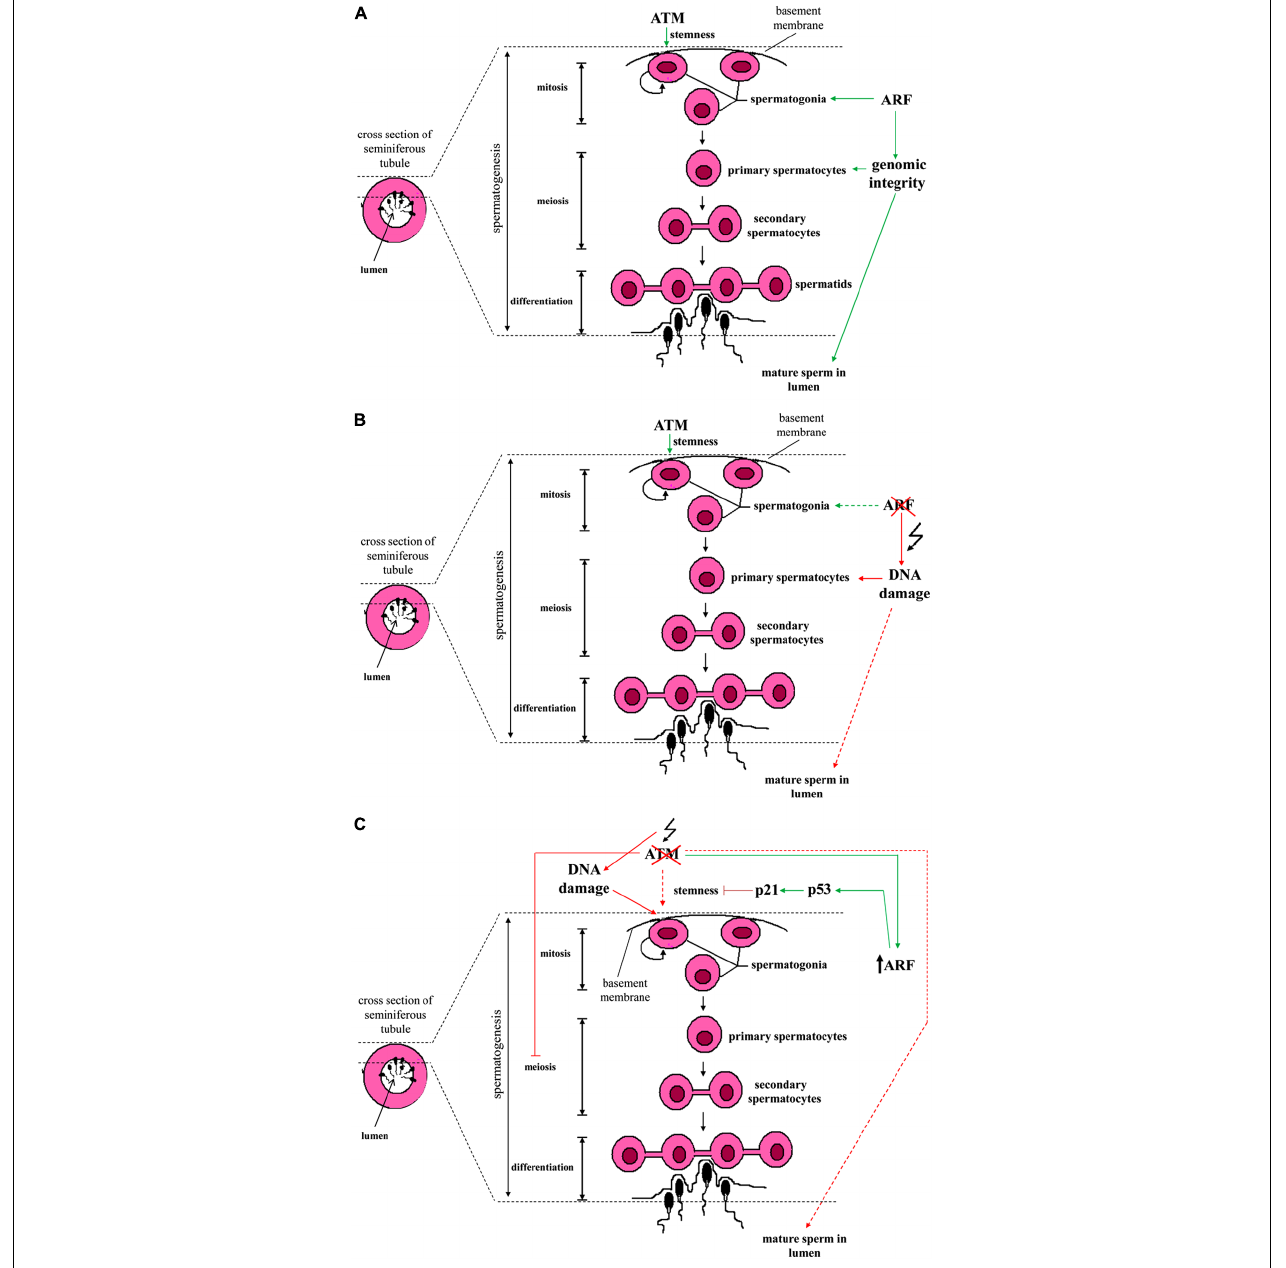
primary spermatocytes is threatened and the production of mature sperm released in the lumen is compromised. (C) Upon ATM deficiency, spermatogonia loose their genomic integrity and ARF undergoes upregulation. Consequently, an ARF-mediated p53/p21 WAF1 / Cip1 growth restrictive pathway counteracts spermatogonial stemness. Due to the fact that ATM deficiency hampers normal spermatocytic meiotic progression (at prophase I), sperm production is compromised (Barlow etal., 1996, 1998; Xu etal., 1996). The different subtypes of spermatogonial cells, Sertoli cells that support spermatogonia, stages and phases of meiosis, the different stages of spermatid differentiation as well as ploidy of cells are not shown here for reasons of simplicity (Colored lines depict ATM and/or ARF effects on spermatogenesis. Dashed colored lines denote weak effect or weak activation. Red lines represent adverse effect, while green ones correspond to physiologic